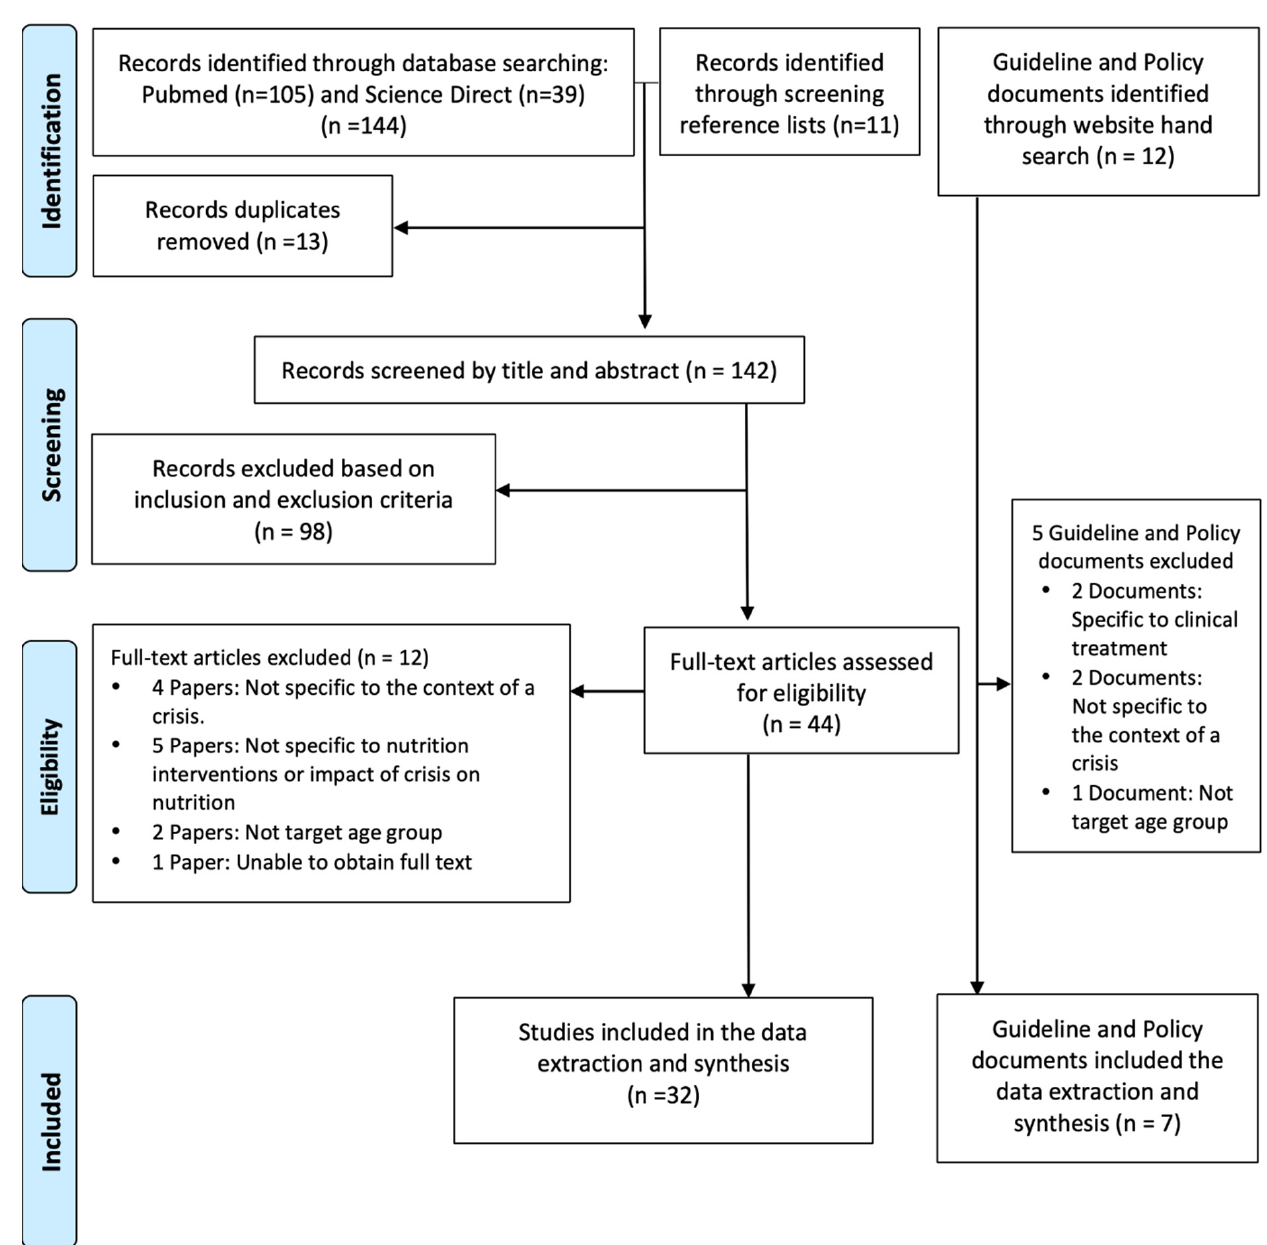
Figure 1. Article screening process. Table 1. Included studies.